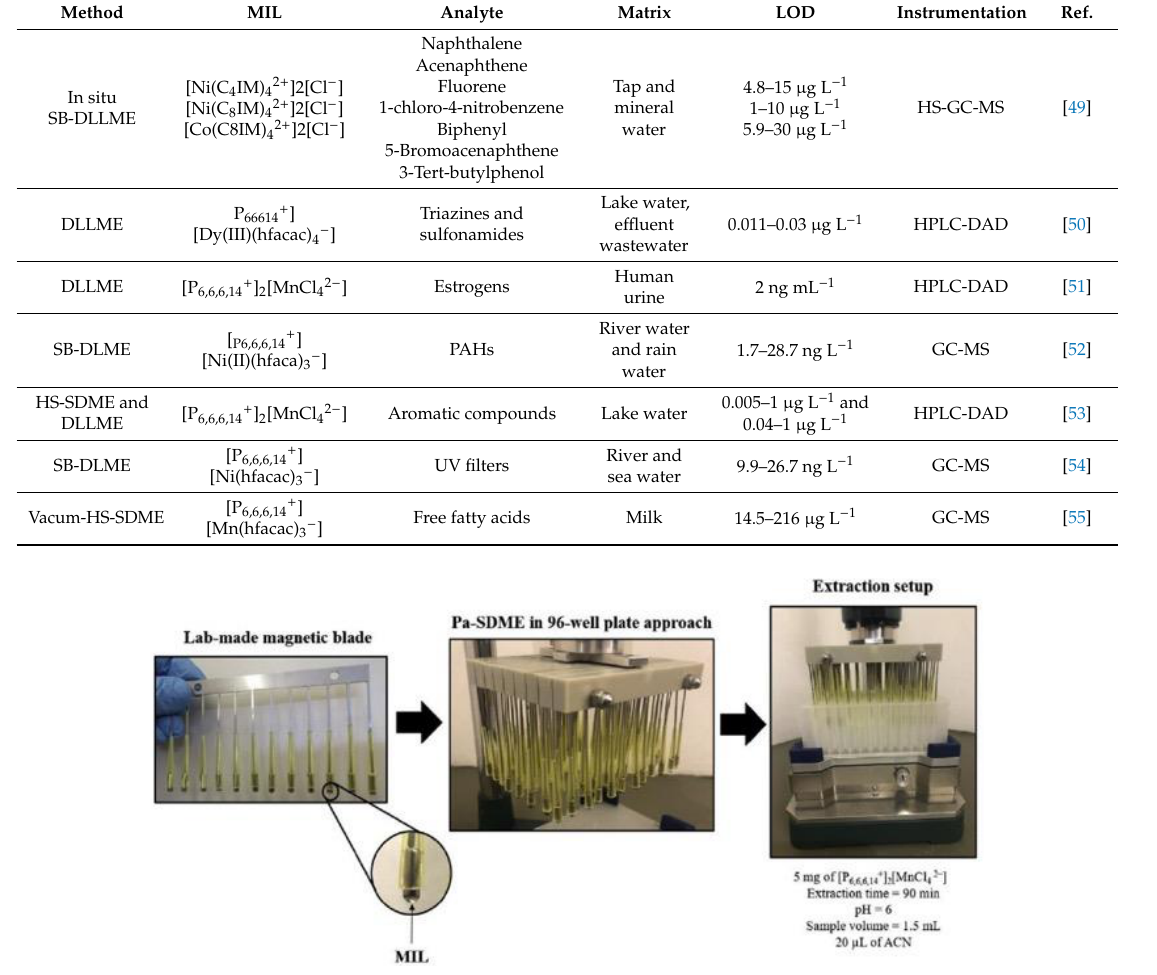
Figure 3. An overview of the extraction procedure using the novel parallel-single-drop microextraction (Pa-SDME)/MIL-based approach. Reproduced with permission from [46], Copyright Elsevier, 2017.